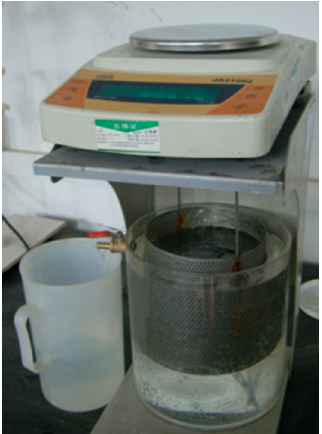
Figure 3. Hydrostatic balance employed in this study.